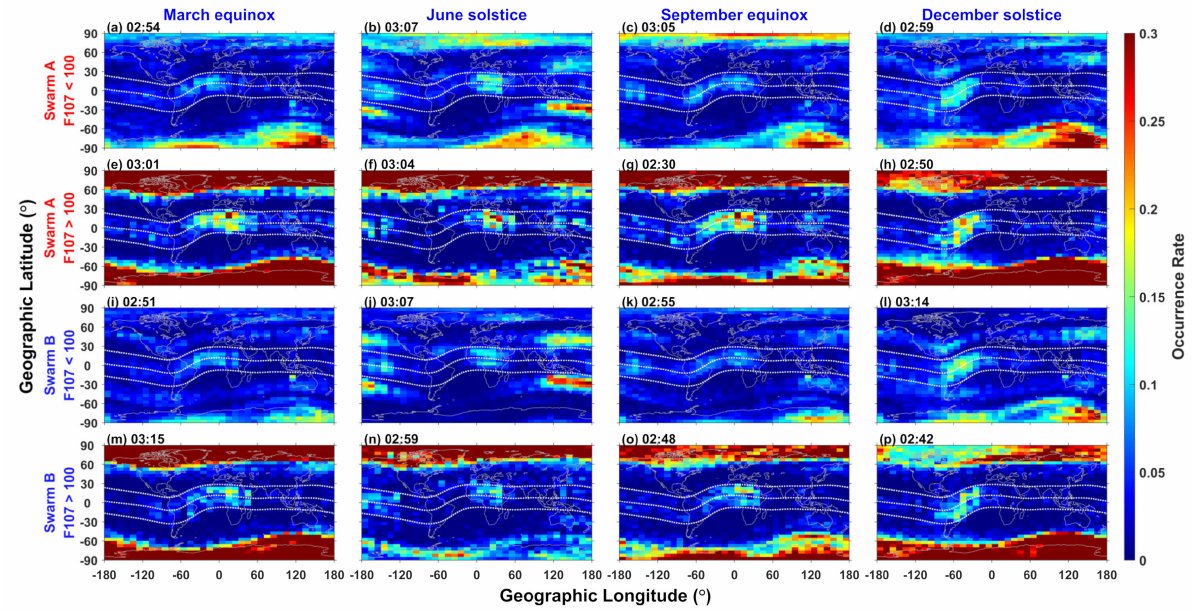
Figure 4. Same as Figure 2 but after midnight. The panels from top to bottom show results for Swarm A (F107 < 100, ( a – d )), Swarm A (F107 > 100, ( e – h )), Swarm B (F107 < 100, ( i – l )), and Swarm B (F107 > 100, ( m – p )), from left to right show results at March equinox, June solstice, September equinox, and December